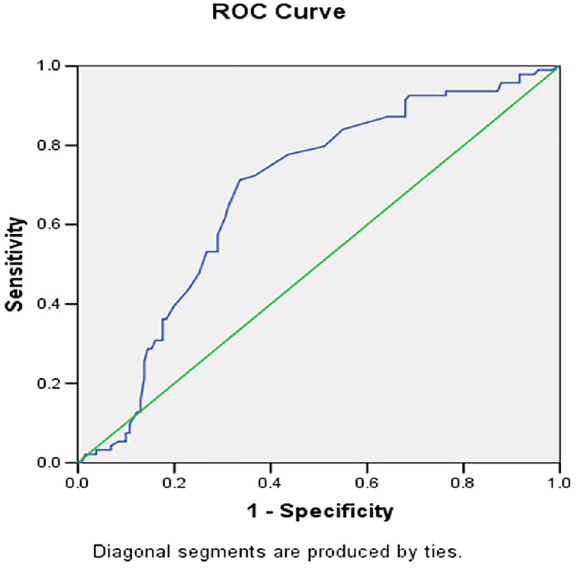
Figure 4. ROC analysis for the JBS 3 risk score showed that a patient with K-L grade 4 of knee OA is more likelytoberunninga10yearsriskofdevelopingCVDatminimum14%withsensitivityof72.3%andspecificity of